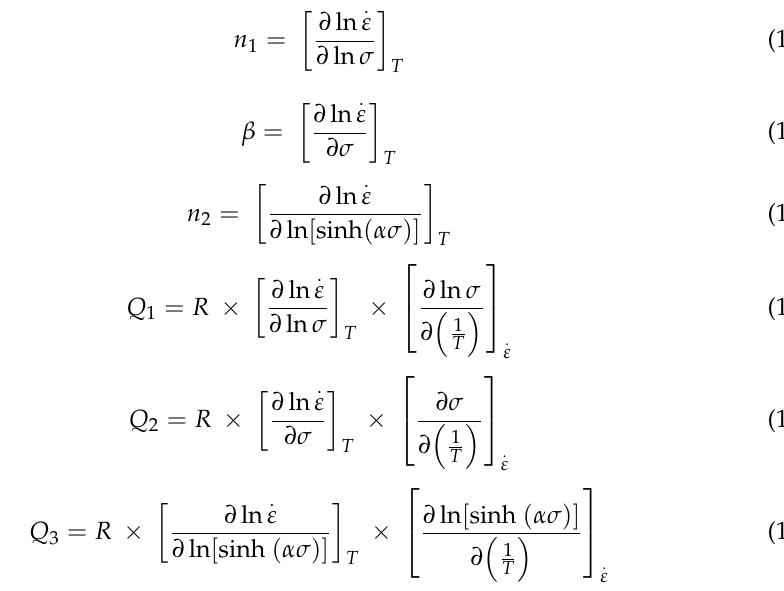
(Figure 5c), and ln sinh ( ασ ) − 1000 (Figure 5d) linear plots. The n 1 , β , and Q 1,2 constants RT . . ε − ln σ and ln ε − σ were computed as the correlation coefficients of the slopes of the ln plots, respectively (Figure 5a,b). While n 2 and Q 3 were obtained from the slope of the . ε − ln sinh ( ασ ) and ln sinh ( ασ ) − 1000 plots of ln (Figure 5c,d). The equations constants at RT a strain of 50% for the investigated alloy are collected in Table